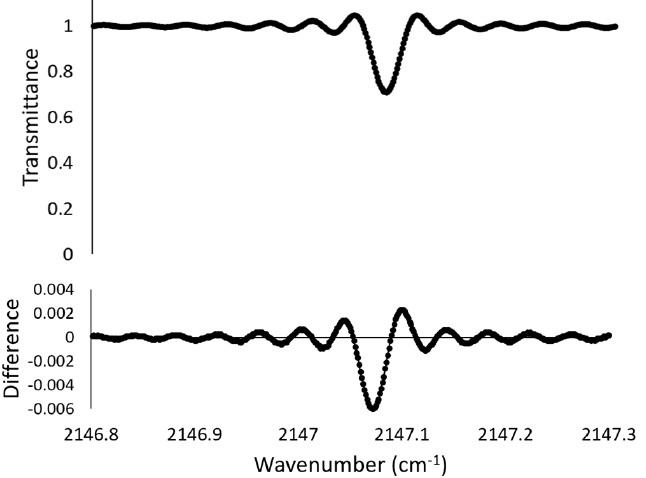
Figure 11. Top: The calculated CO spectrum for a tangent height near 59.5 km in occultation sr10063. Bottom: The difference in the calculated spectrum when Doppler effect smearing was included versus when it was ignored. Absorption was greater in the case where Doppler effect smearing was